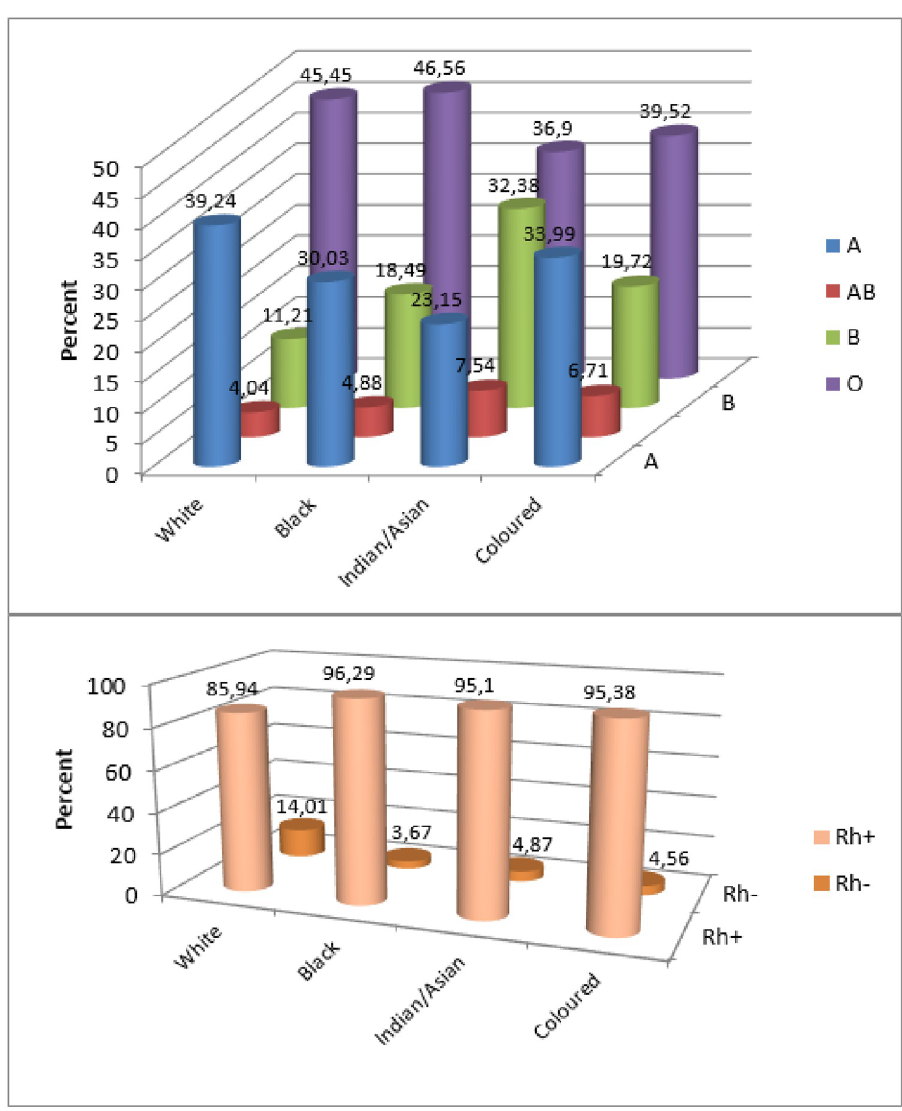
Fig 1. ABO and RhD blood group frequencies by